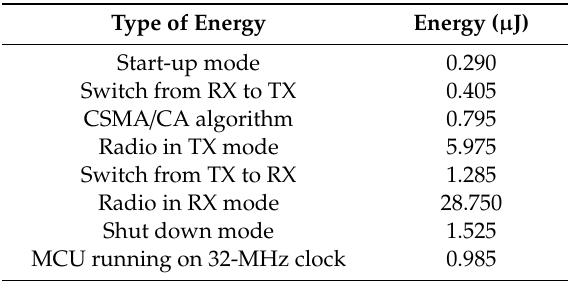
Table 4. Obtained energy model for the Zigbee sensor node [55].